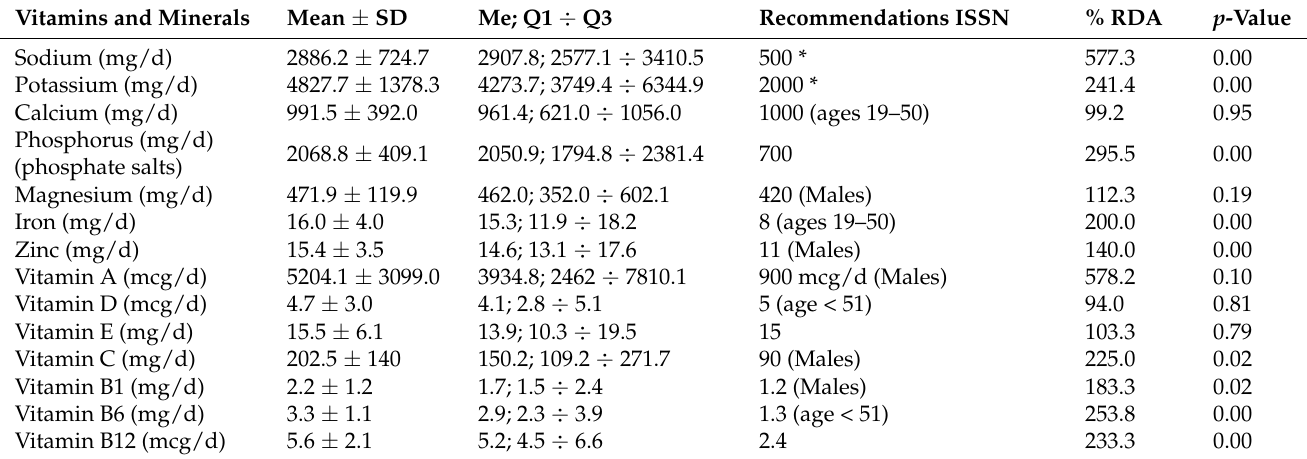
Table 3. Dietary intake of vitamins and minerals in the windsurfers’ daily